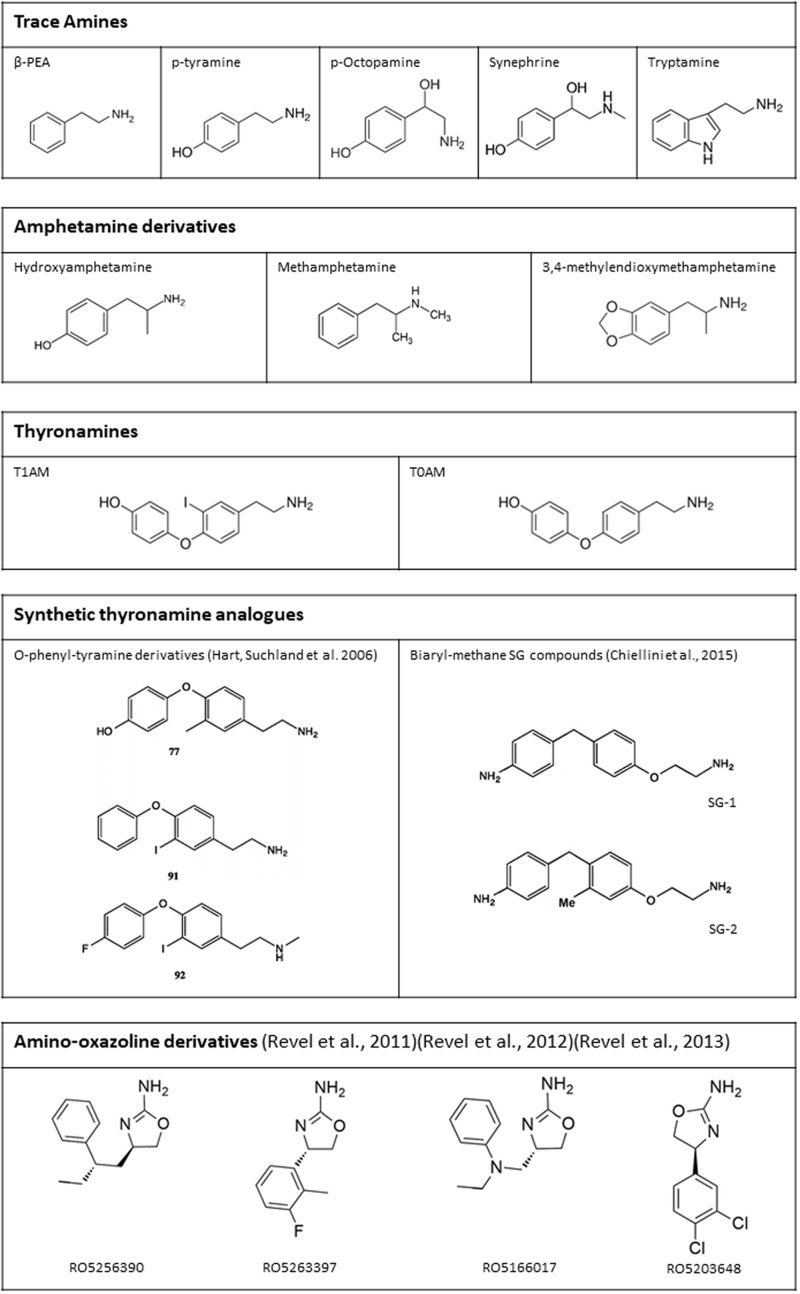
Chemical structure of some endogenous and synthetic TAAR1 ligands. Additional drugs which have been reported to act on TAAR1 are mentioned in the text (receptor pharmacology).